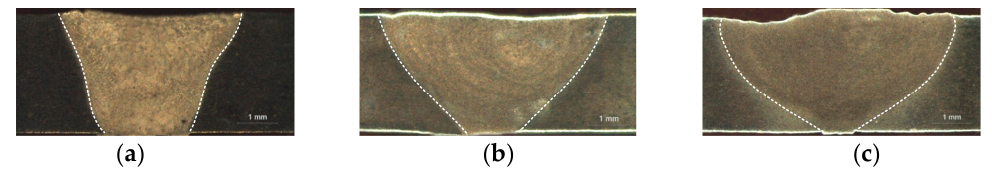
Figure 4. Typical PCALW morphology of ( a ) I 0 = 0, autogenous laser welding; ( b ) I 0 = 4 kA; and ( c ) I 0 = 8 kA.